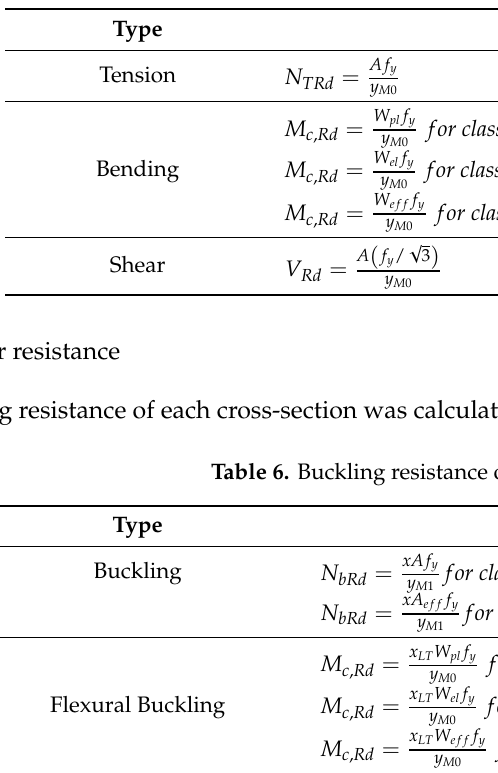
Table 5. Design resistances of cross-sections.